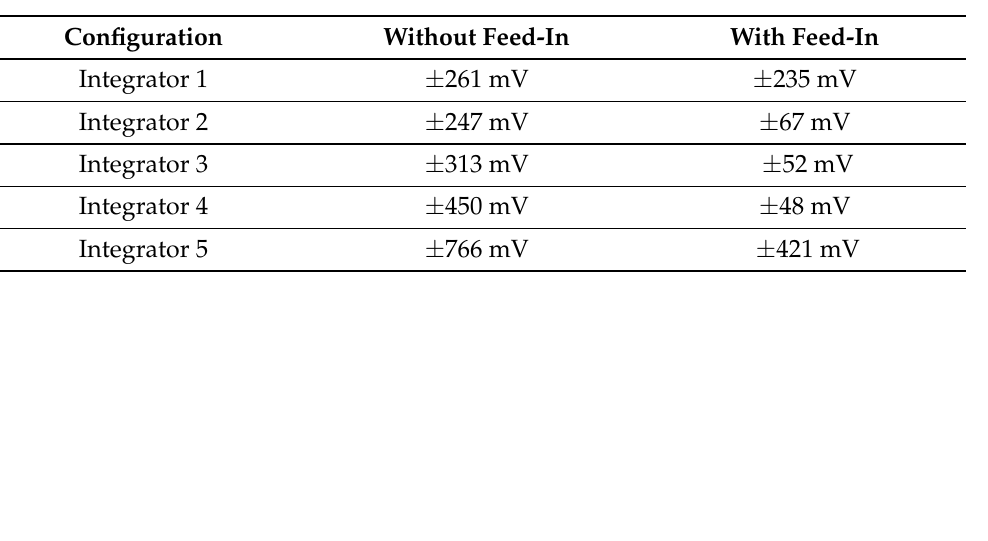
4.4dBFS Full-scale Quan- −